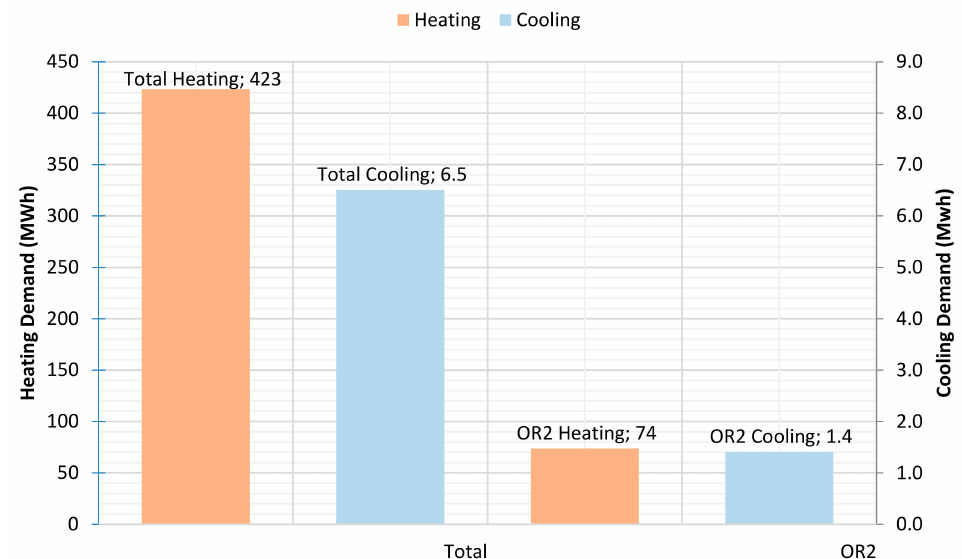
Figure 9. Annual energy demand in the surgical suite and operating room 2 (Case